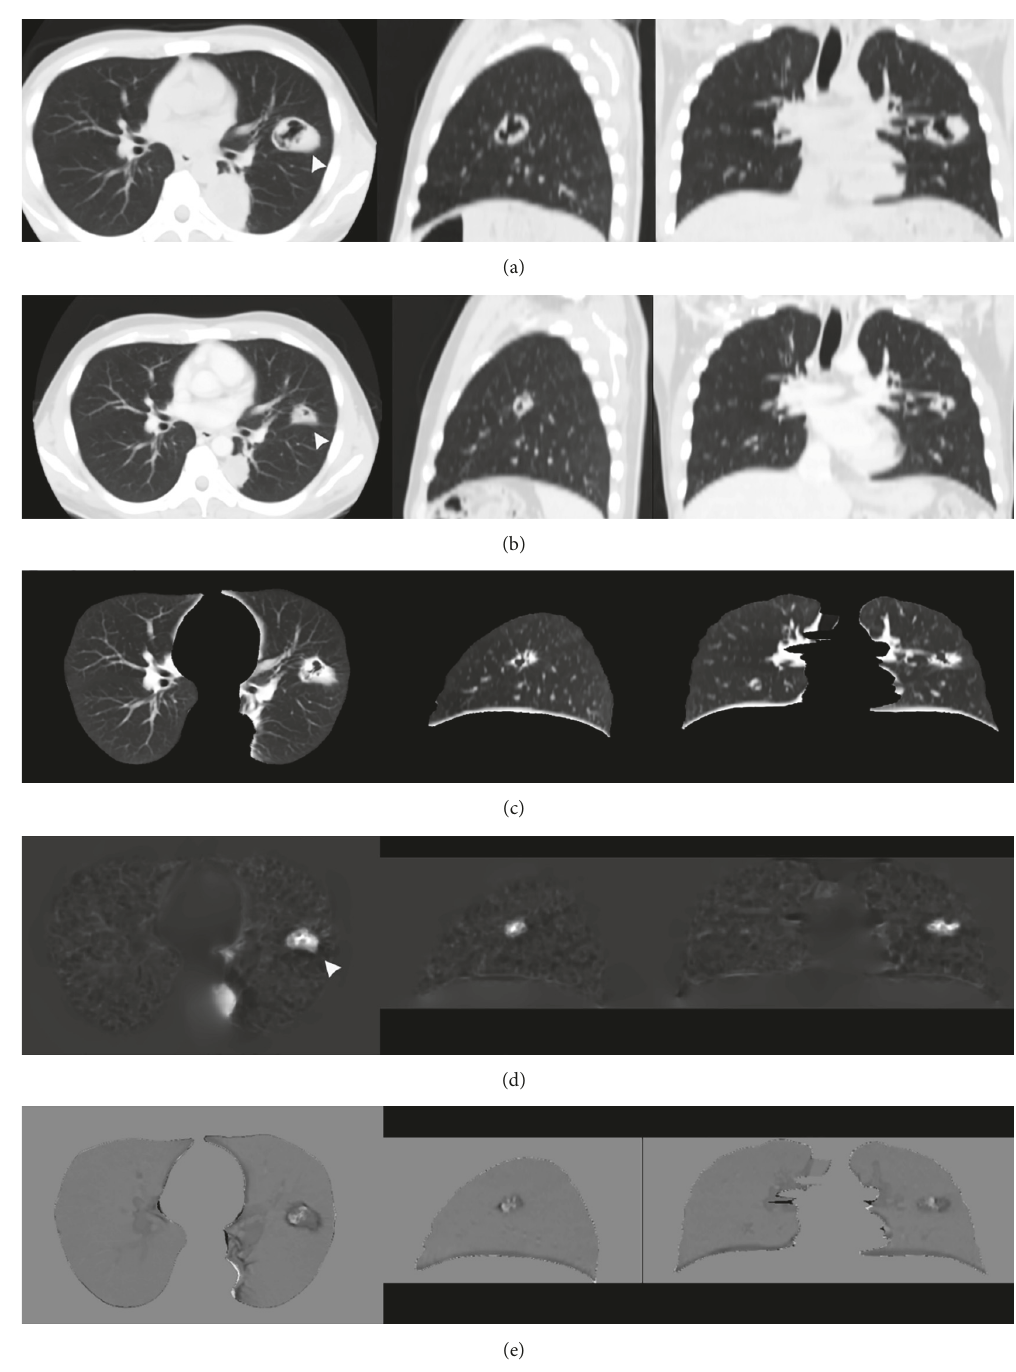
Figure 3: Comparison of the alignments of large lung lesions after DIR. Columns from left to right are the axial, sagittal, and coronal planes. The white arrows indicate lesions in the left lung. (a) Moving images (long and short diameters = 71 and 52 mm, resp.). (b) Fixed images (interval of 3 months 20 days; long and short diameters = 49 and 31.5 mm, resp.). (c) Warped moving images (long and short diameters = 55 and 36.8 mm, resp.). (d) Log-Jacobian image of the deformation field. (e) Subtraction